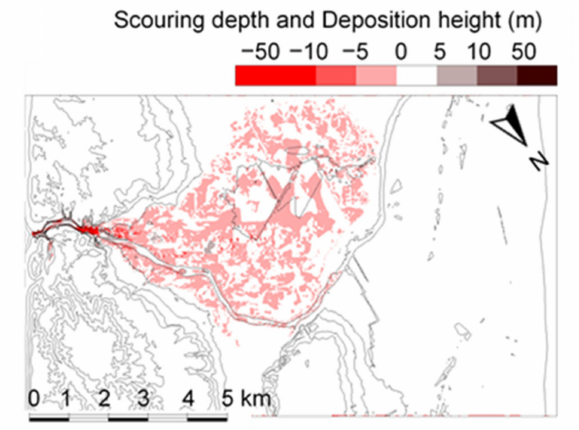
Figure 16. (Case–1). Topography change, 30 min after the start of the calculation.